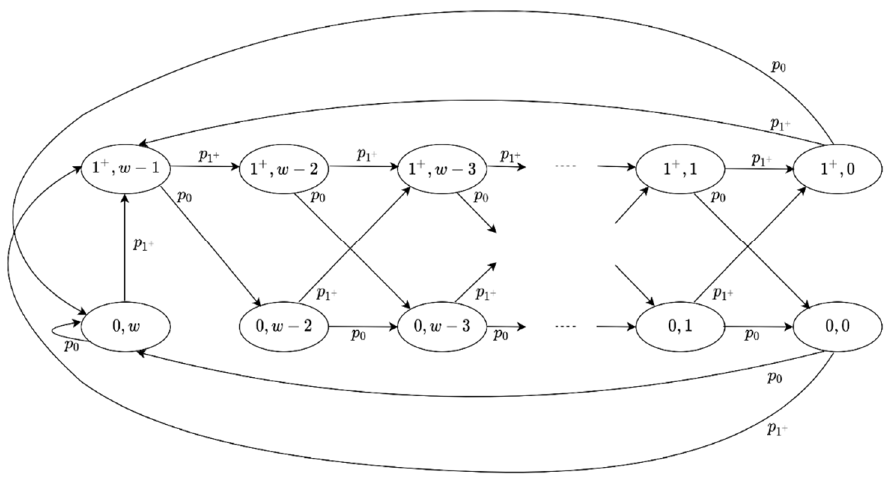
Figure 2. Discrete Time Markov Chain.